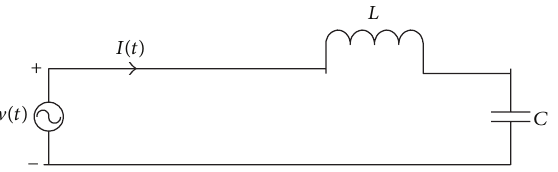
Figure 3: Illustration of LC resonance circuit in series with damping 𝑅 = 0